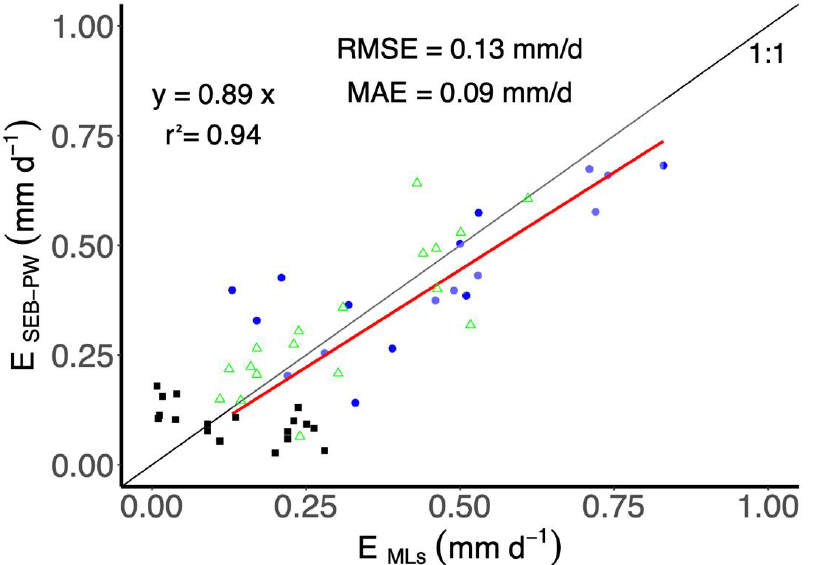
Figure 10. Relationship between nightly E estimated by the SEB–PW model and measured with micro–lysimeters (MLs). Black squares and green triangles represent non-wetted and wetted areas, respectively, and blue circles represent the mean of soil E. deviation from the 1:1 line (Figure 11a). Daily E estimations by the SEB-PW model pre- sented an underestimation with respect to the E measured with MLs (r 2 of 0.96 and regres- sion slope of 0.88). The daily weighted average of E estimated by the model for micro- sprinkler (site S1) and drip (site S2) irrigation systems were 1.5 and 1.1 mm d −1 , at site S1 and S2, respectively, while those measured with MLs were 1.6 and 1.4 mm d −1 , respec- tively. The maximum daily E value measured with MLs was 3.0 ± 0.05 mm d −1 with the micro-sprinklers and 2.1 ± 0.04 mm d −1 with the drip system and, in both cases, was ob- served a day after irrigation was applied. Furthermore, daily E was lower (approximately 0.4 mm d −1 ) each day before irrigation compared to 2 or 3 days after irrigation. When com- pared to field measurements, daily E estimates from the SEB-PW model resulted in an RMSE of 0.4 mm d −1 , an MAE of 0.3 mm d −1 , an NSE of 0.69, and a da of 0.88.